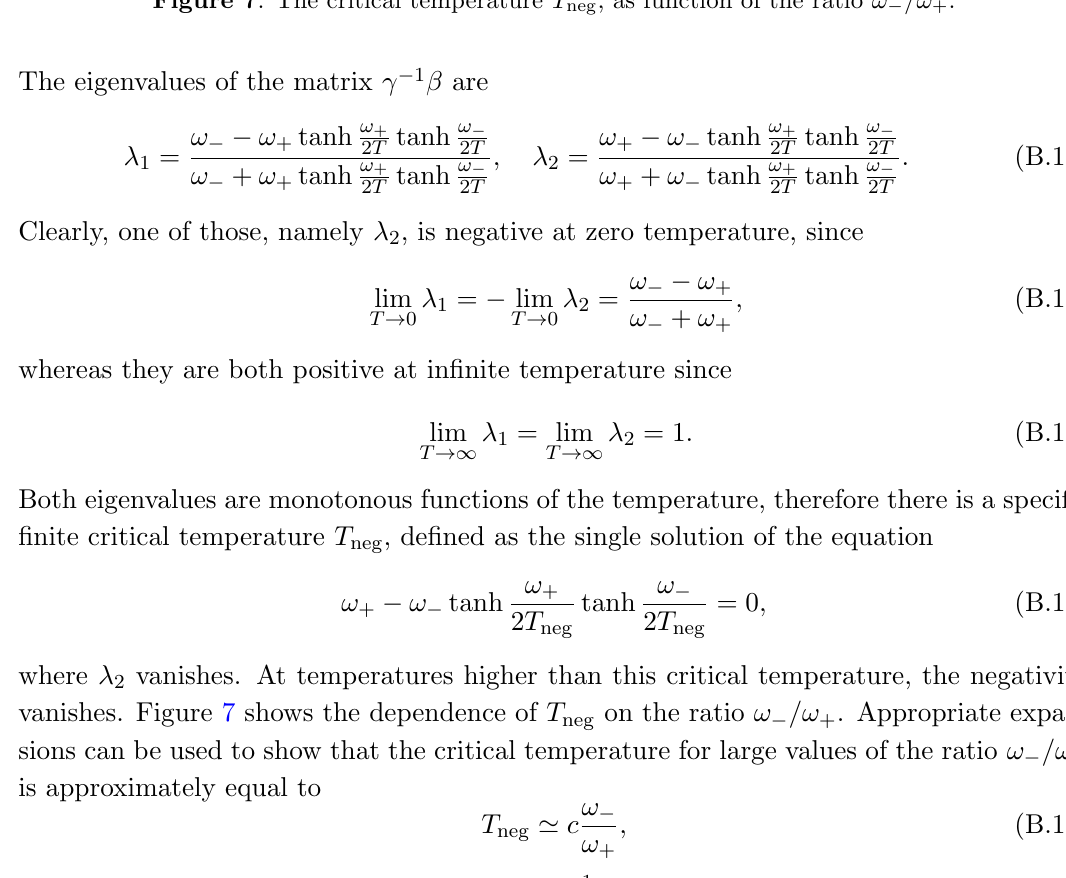
Figure 7 . The critical temperature T neg , as function of the ratio ! (cid:0) =! +